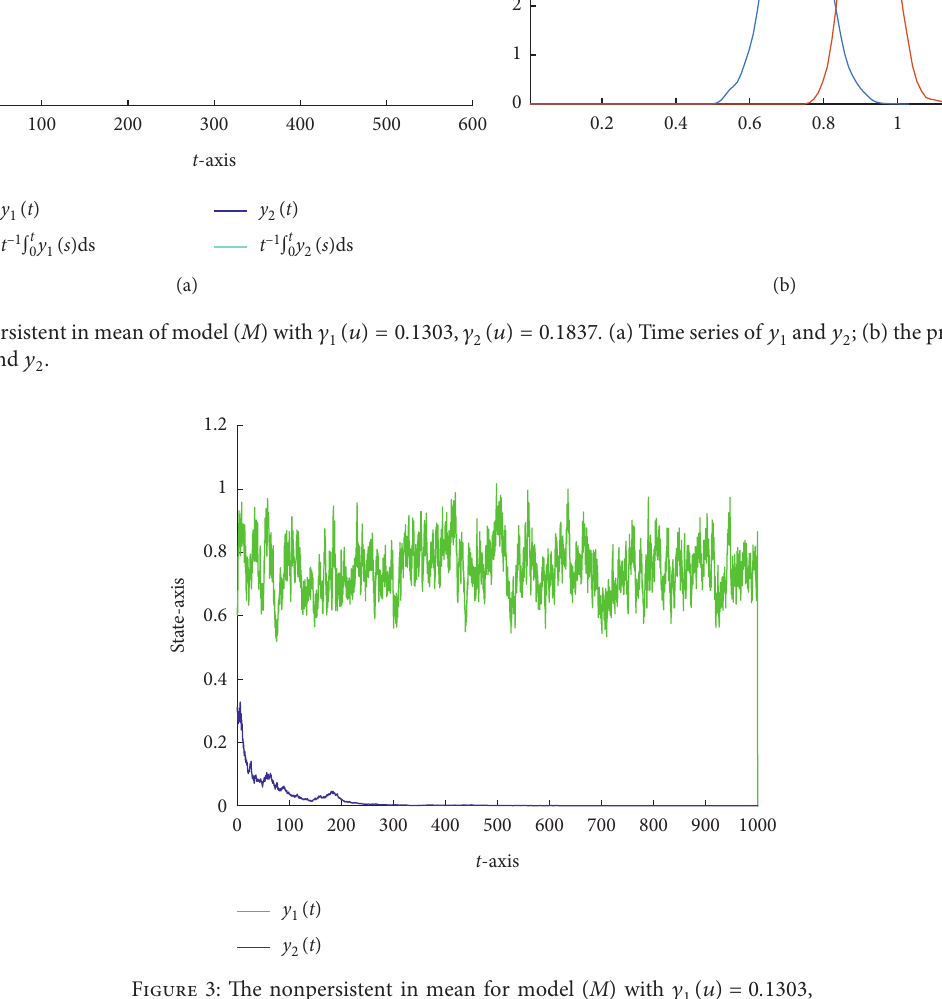
Figure 3: The nonpersistent in mean for model ( M ) with c